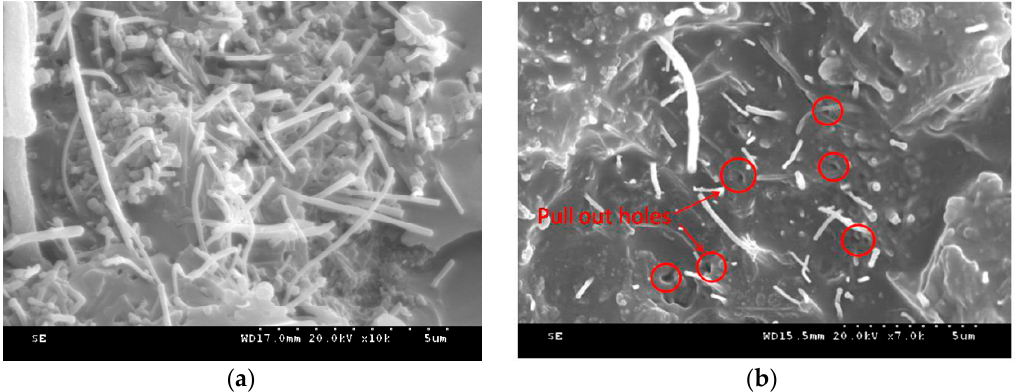
Figure 13. SEM diagram. ( a ) CNF lap conduction; ( b ) CNF pull out voids.